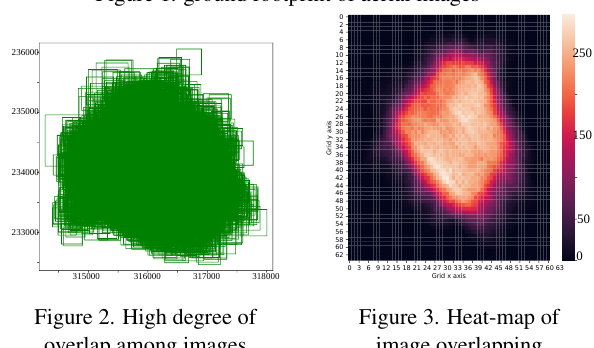
Figure 2. High degree of overlap among images